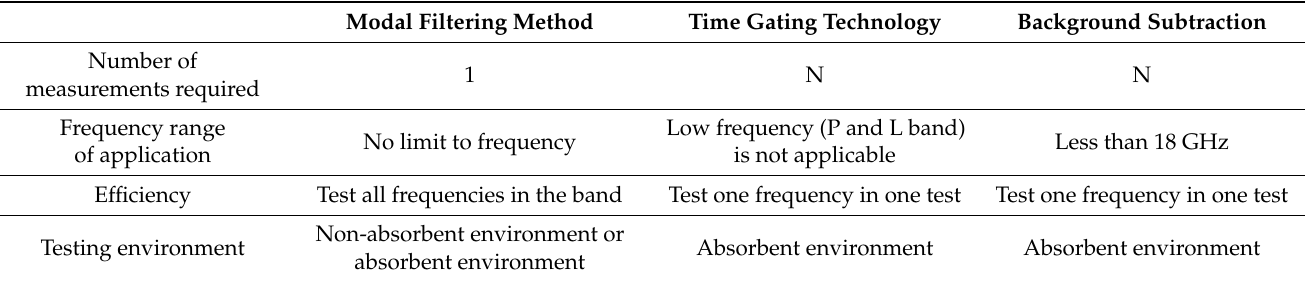
Table 1. Comparison of different methods. N is the quantity of frequencies